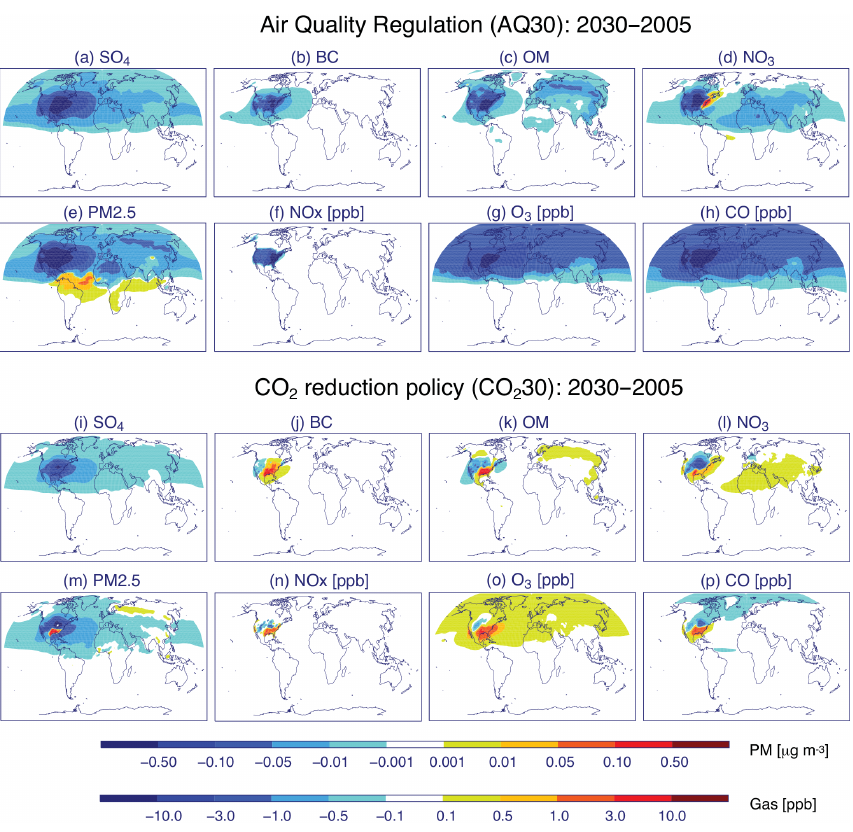
Figure 3. Spatial distributions of changes in surface PM and gas pollutants’ concentrations due to the impact of (a–h) the air quality regulations (AQ30) and (i–p) the CO 2 reduction policy (CO 2 30). Table 4. Changes in the US mean air pollution in 2030 and 2055 with respect to 2005 (averaged over the 50 states) due to the air quality regulations and CO 2 reduction policy that are divided by the model baseline 2005 (bs05)